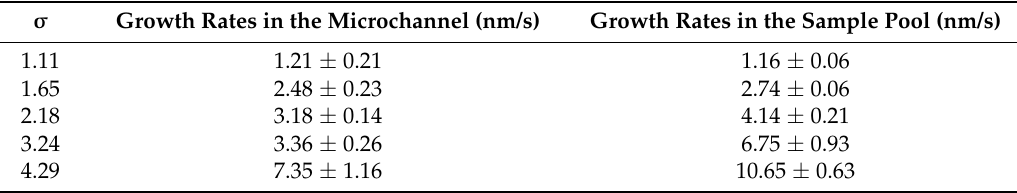
Table 2. The growth rates of the (110) face of lysozyme